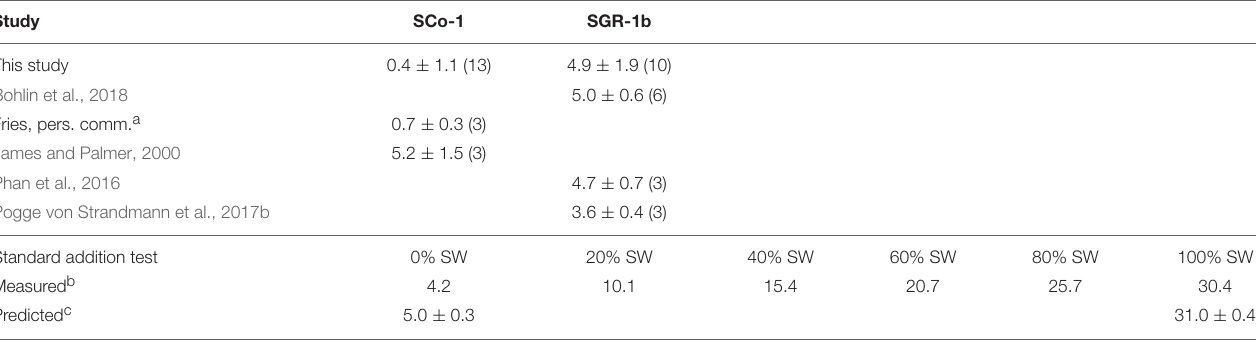
TABLE 1 | Comparison of Li isotope values of USGS sedimentary rock standards measured in this study with literature values and measurements of seawater-SGR-1b mixtures from a standard addition test. Study